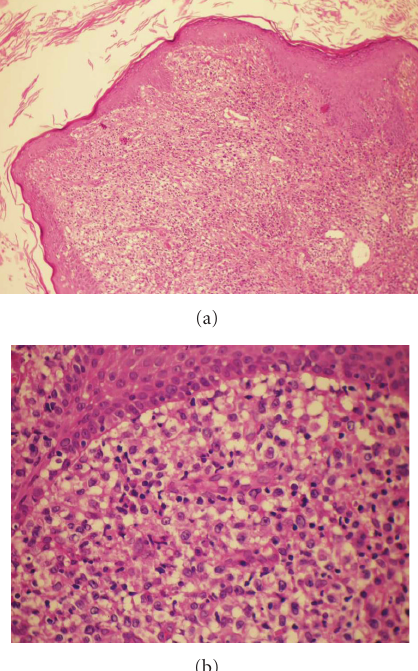
Figure 2: (a) Histopathology revealed a di ff use, monomorphous, nonepidermotropic infiltrate of large epithelioid cells throughout the entire dermis. (stain type—Hematoxylin and eosin; origi- nal magnification: × 100). (b) Histopathology revealed a di ff use, monomorphous, nonepidermotropic infiltrate of large epithelioid cells throughout the entire dermis. (stain type—Hematoxylin and eosin; original magnification: ×